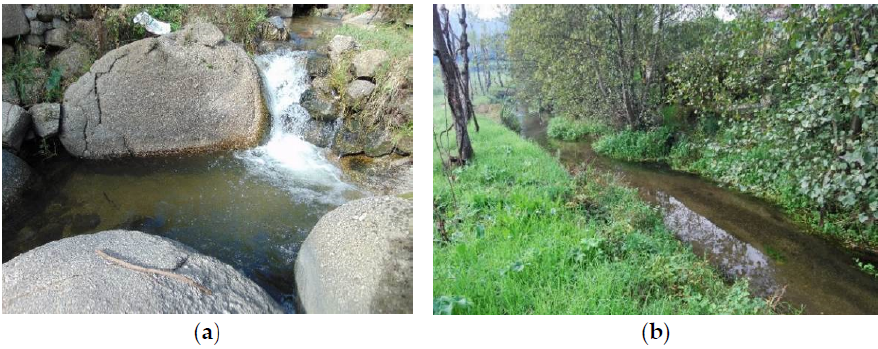
Figure 6. Aspects associated with Section E: ( a ) Boulders; ( b ) Sand. - Sections F and H: Banktop land-use and vegetation structure (Table